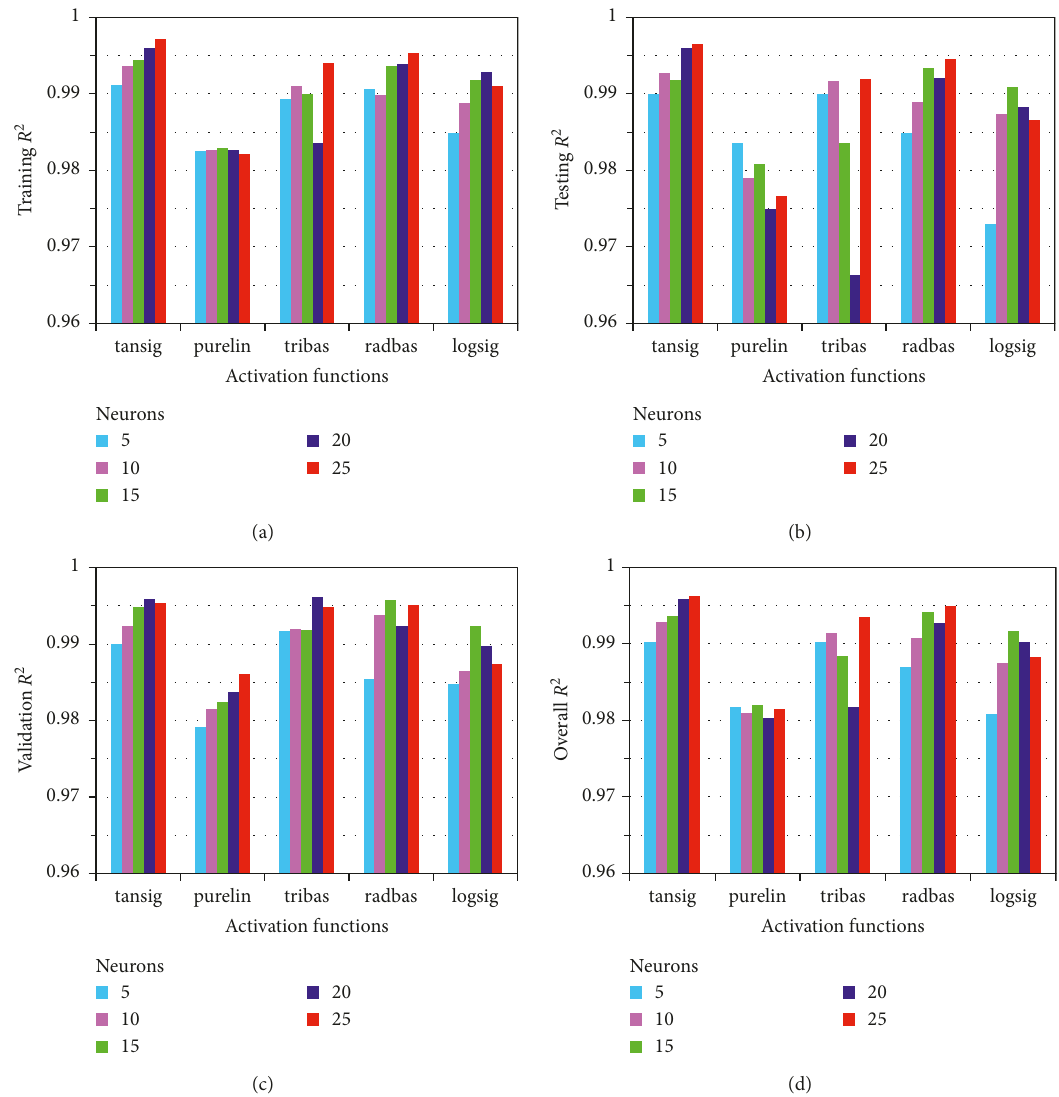
Figure 4: The coefficient of determination ( R 2 ) values for the prediction of thermal conductivity.